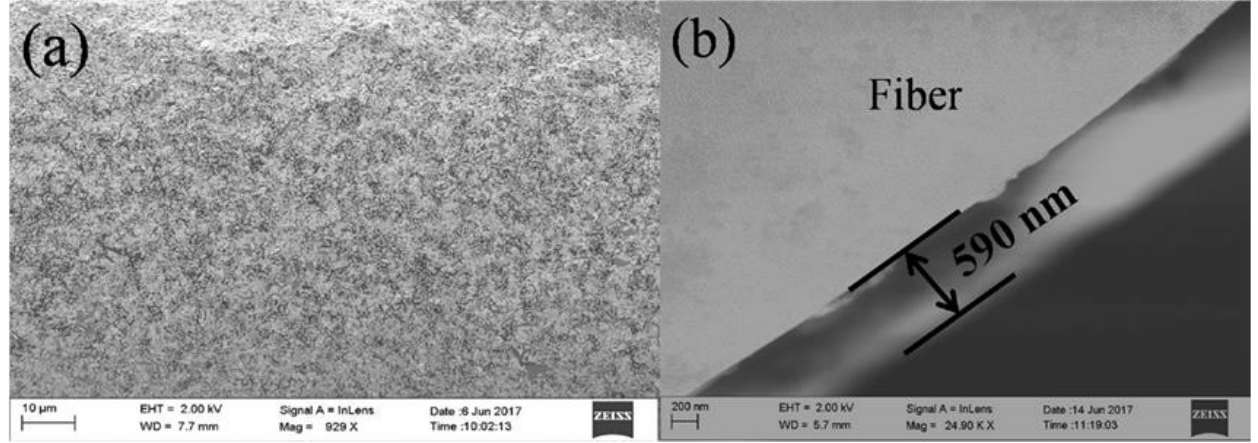
Figure 12. SEM images of ( a ) the side surface of the LPFG and ( b ) cross section of the composite membrane-coated LPFG. Reprinted with permission from [96]. Copyright © 2018 Elsevier B.V.